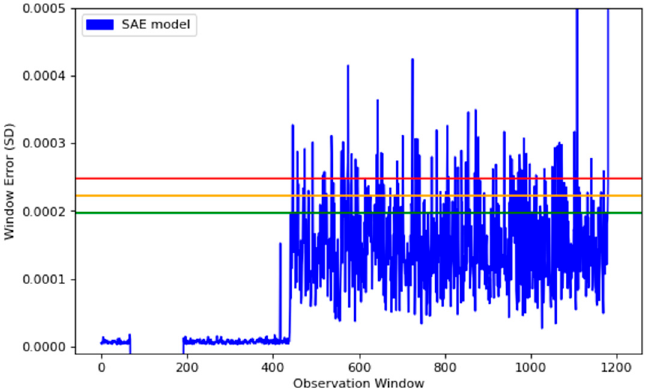
Figure 12. This plot shows the traditional SAE, along with its subsequent thresholds, with green, orange and red being 99.95, ~99.975 and 99.99 percentile error from our model. The two models were then compared based on their detection, using the percentile measure to calculate the upper bounds for an error rate to be considered normal. The confusion matrix is shown below in Figure